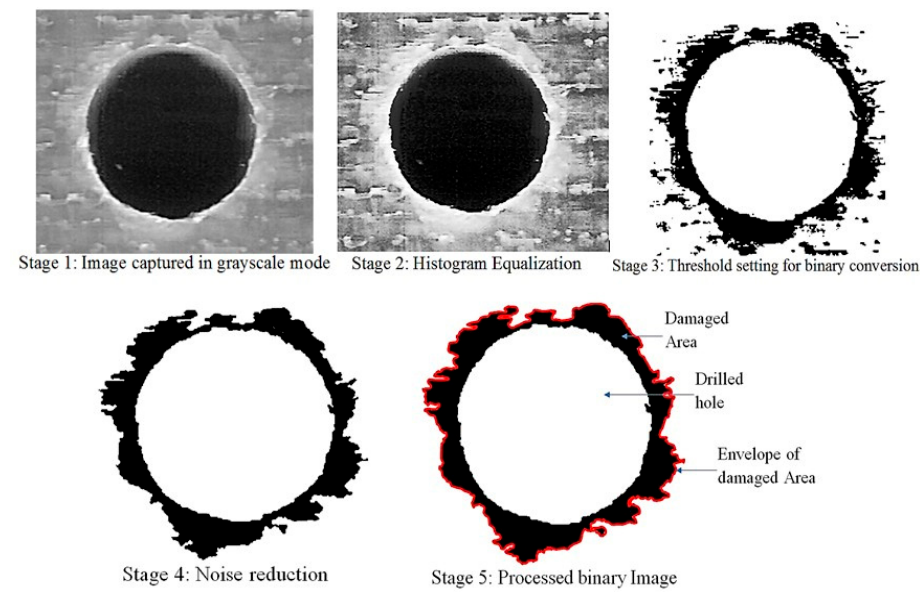
Figure 2. Image processing procedure [27]. Table 2. Taguchi’s l-27 orthogonal array. Table 3 lists the output responses for various drilling situations, including both peel-up and push-out delamination, thrust force, temperature, hole size errors and circularity errors. Table 3. Experimental